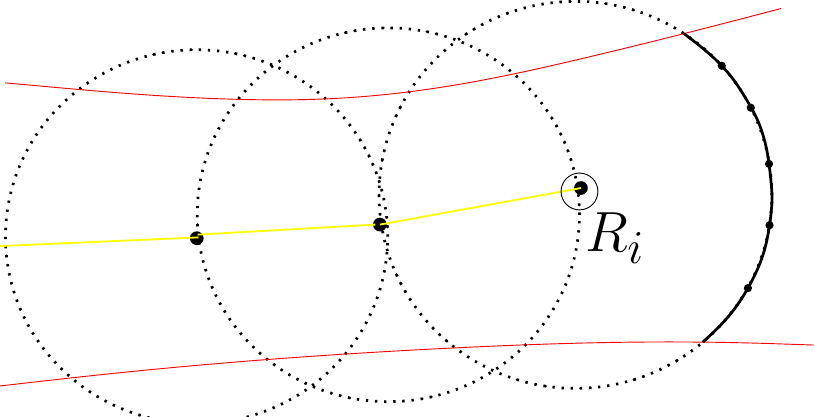
Figure 3. R i keeps deploying a new virtual node. FrontierPoints are plotted with large dots on the footprint of the rightmost node.